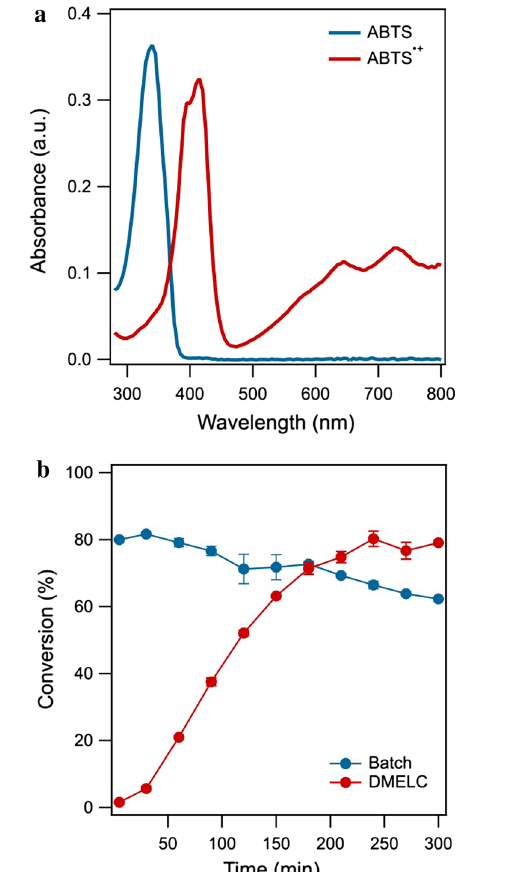
Fig. 3 a Absorbance spectra of ABTS and its cation radical, ABTS • + . b Time‑course of ABTS • + production by DMELC and batch reaction